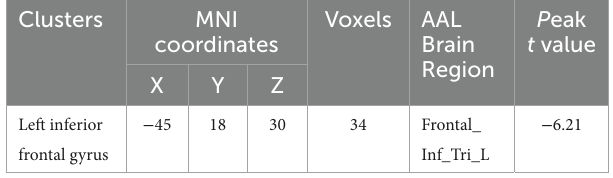
TABLE 4 Brain regions showing decreased FC in RA after treatment compared with baseline.